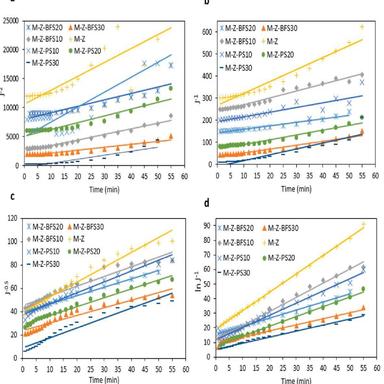
Linearized plots of permeate flux J (l m− 2 h− 1 ) versus time for various pore blocking models: a) Cake formation model, b) Intermediate pore blocking model, c) Standard pore blocking model, d) Complete pore blocking model.